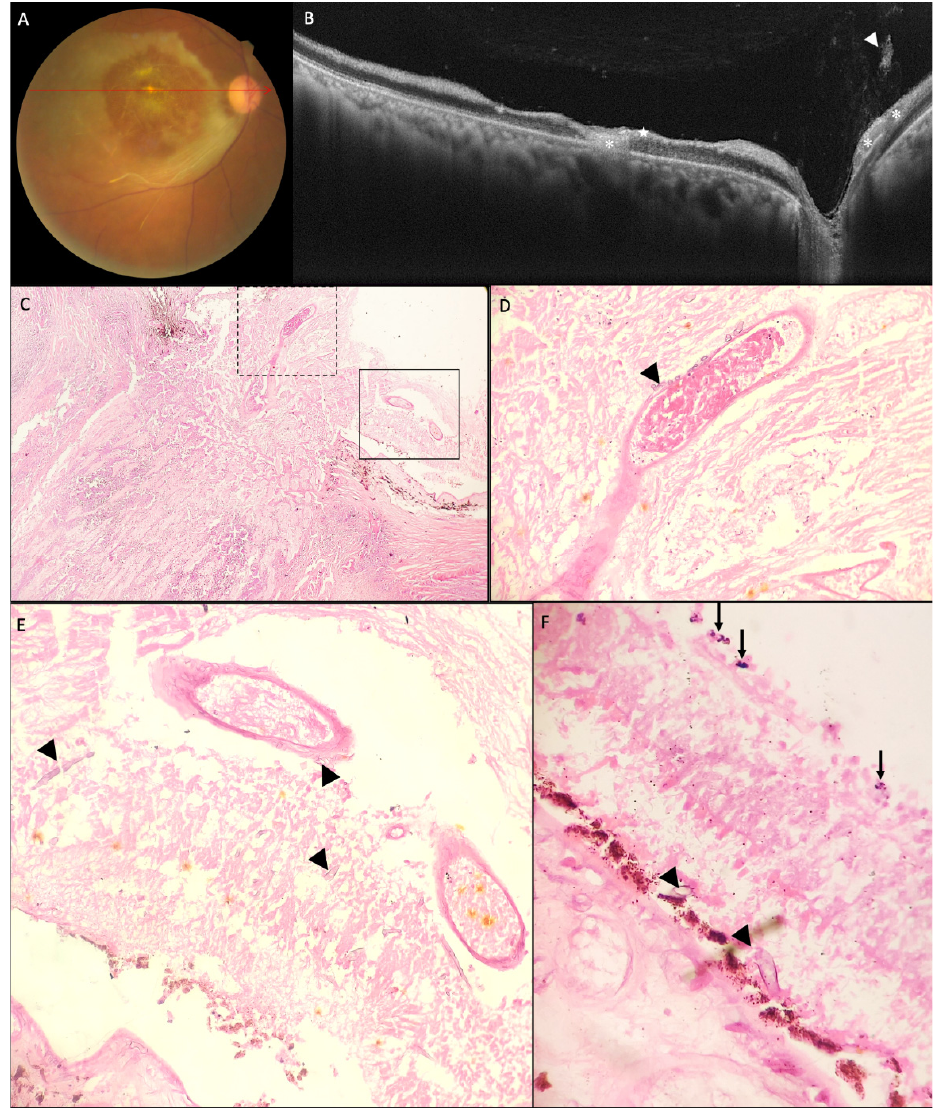
Figure 4. Fundus photograph, SD-OCT image and histopathological micrographs of a representative case (case 13): ( A ) Fundus photograph shows resolving retinal opacification with center clearing and inferotemporal arterial attenuation. ( B ) The corresponding SD-OCT image shows, thinned out, hyperreflective, disorganized inner retina along (white star) with outer retinal thinning along, photoreceptor layer and ELM layer disruption. Hyperreflective, disorganized retina seen at fovea suggestive of foveal scarring (white asterisk). Vitreous haze overlaying the second order vessel (white arrow head) with few vitreous cells in posterior vitreous. Photomicrograph ( C ) shows optic nerve displaying edematous and degenerative changes. (H&E; 40×). ( D ) The high-power view of the dotted line square in image ( C ) shows thrombosed blood vessel surrounded by mucor hyphae (black arrow head). (H&E; 200×). ( E ) The high-power view of the solid line square in image ( C ) shows necrotic retinal tissue displaying disruption of the normal lamellar architecture along with presence of broad aseptate ribbon-like mucor hyphae (black arrow head) in the necrotic tissue (H&E; 200×). ( F ) Photomicrograph shows retinal tissue with presence of mucor hyphae (black arrow head) in the necrotic layer of rods and cones along with neutrophils (black arrow) in the necrotic outer nuclear layer. (H&E; 400×).